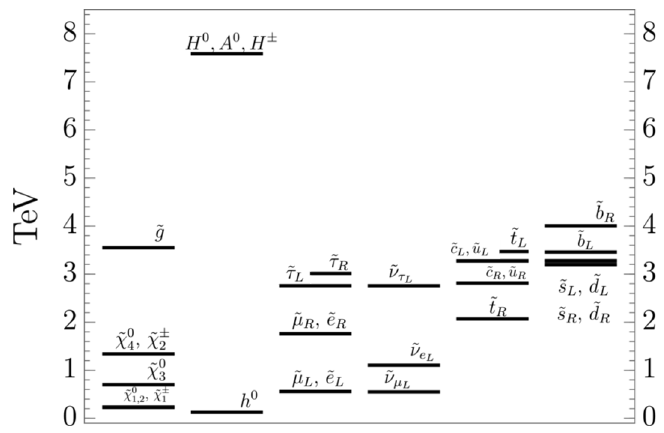
Figure 7 . Spectrum for the benchmark point in table